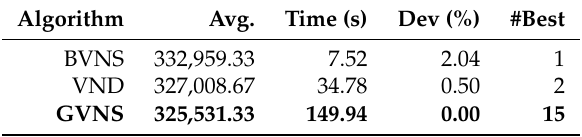
Table 5. Comparison among the different VNS variants for the preliminary set of